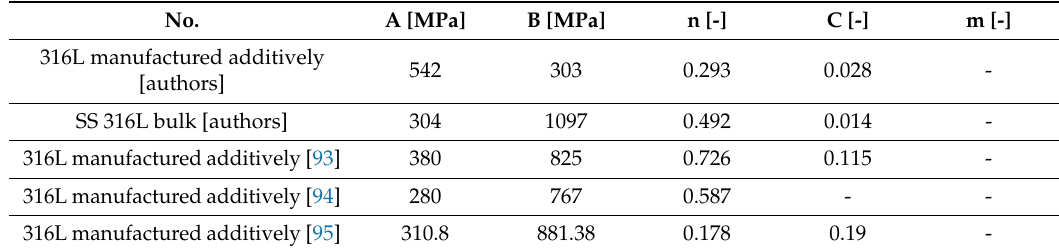
Table 3. SS316L material parameters identified through the use of Johnson–Cook constitutive relations.